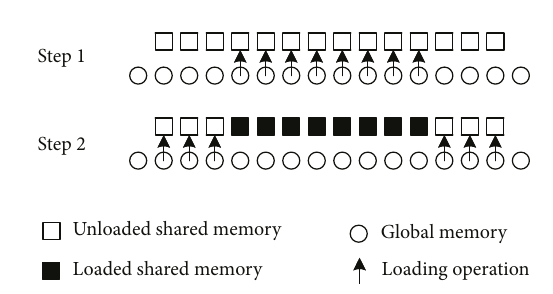
Figure 5: Dependence region of an 8 3 block.